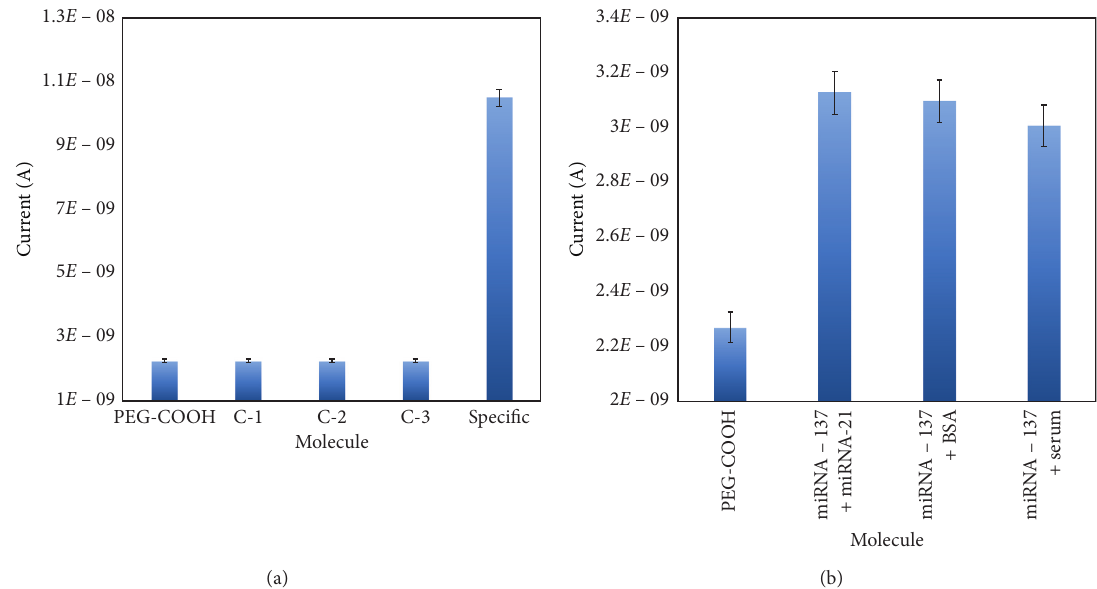
Figure 5: (a) Specific miRNA-137 detection. Experimented with control sequences of miRNA-21 (C-1) and single (C-2) and triple (C-3) base mismatched miRNA-137 sequences. Control sequences did not show any particular current response with complementary miRNA-137 compared with the specific hybridization (S). (b) Specific miRNA-137 detection. Experimented with mixed miRNA-137, miRNA-21, and serum. Mixing other molecules did not interfere the hybridization of miRNA-137 with complementary sequences and confirms the selective detection.